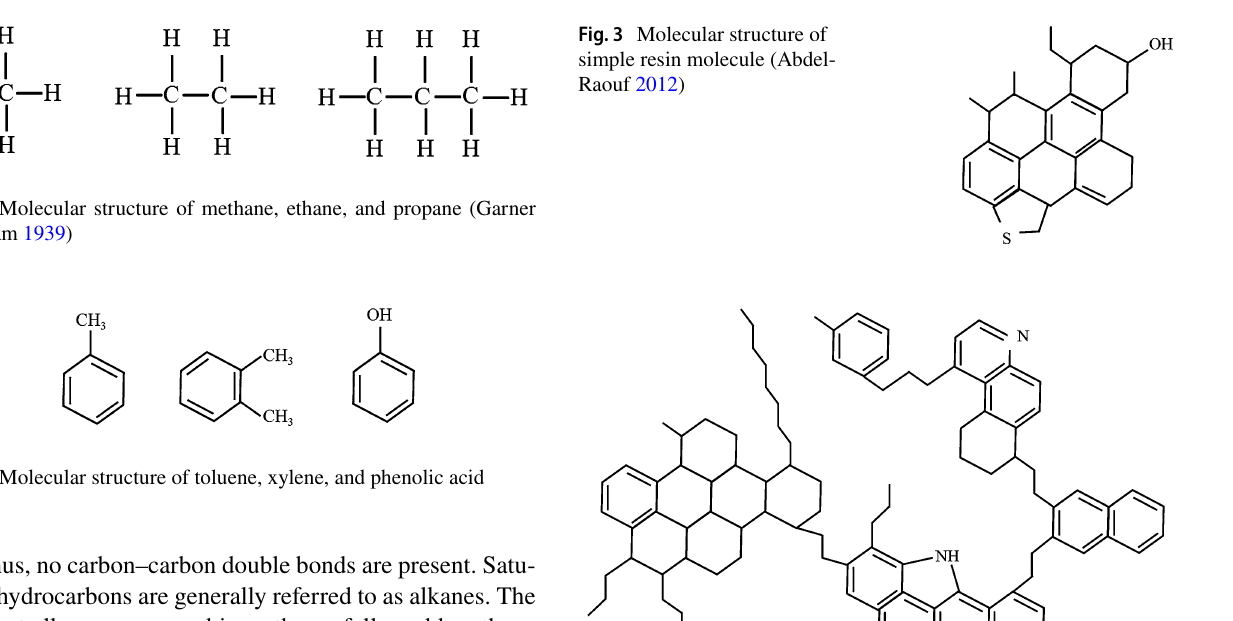
Fig. 3 Molecular structure of simple resin molecule (Abdel- Raouf 2012)